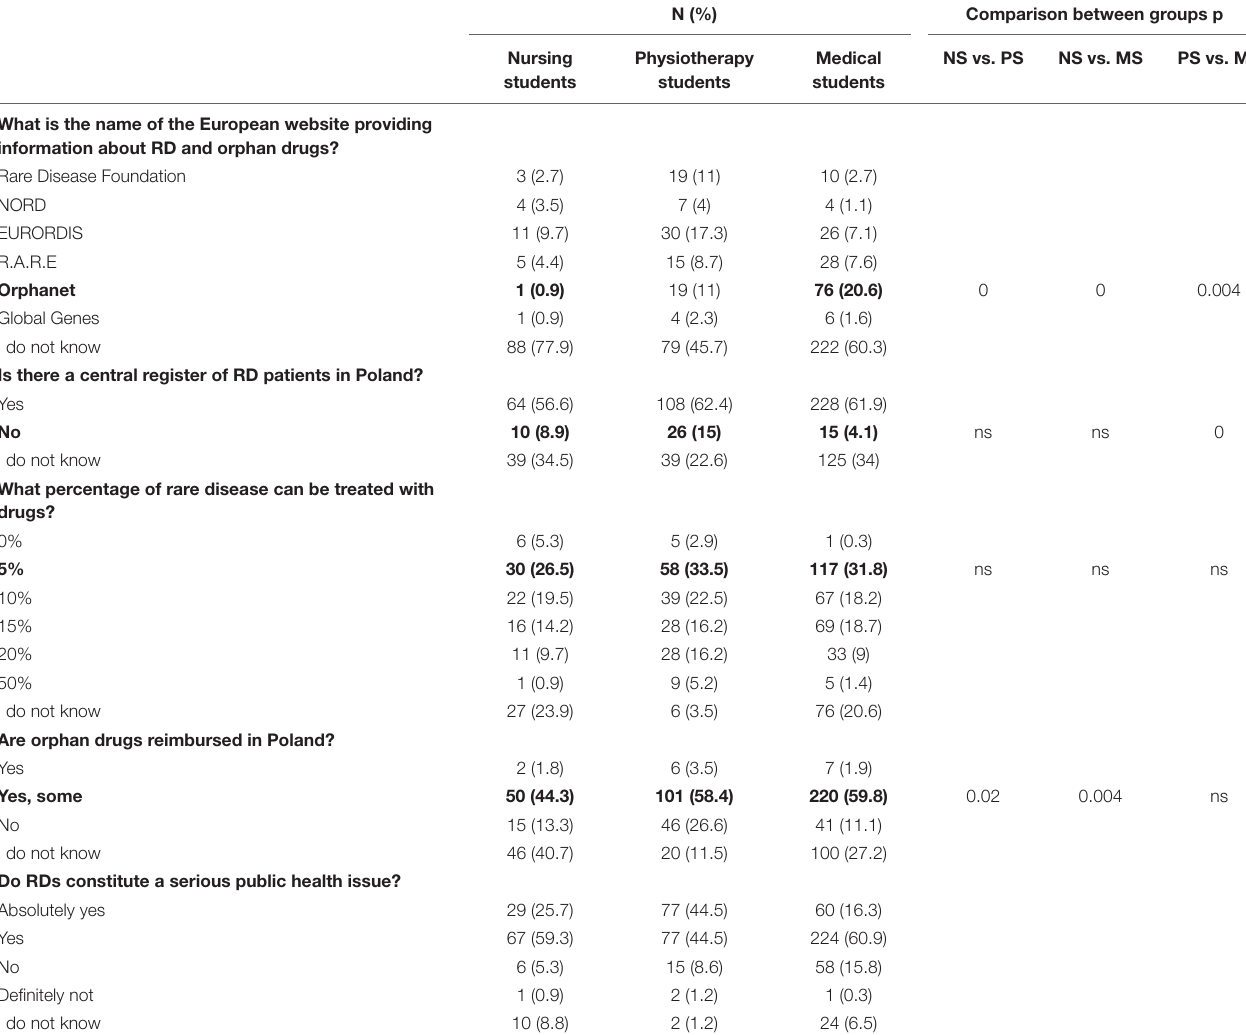
TABLE 4 | Students’ knowledge about the healthcare system for RD patients.